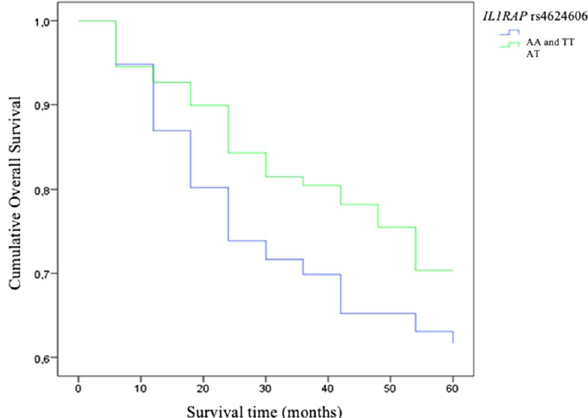
Table 4 Association between study variables and LSCC patients’ mortality in univariate Cox proportional Hazard